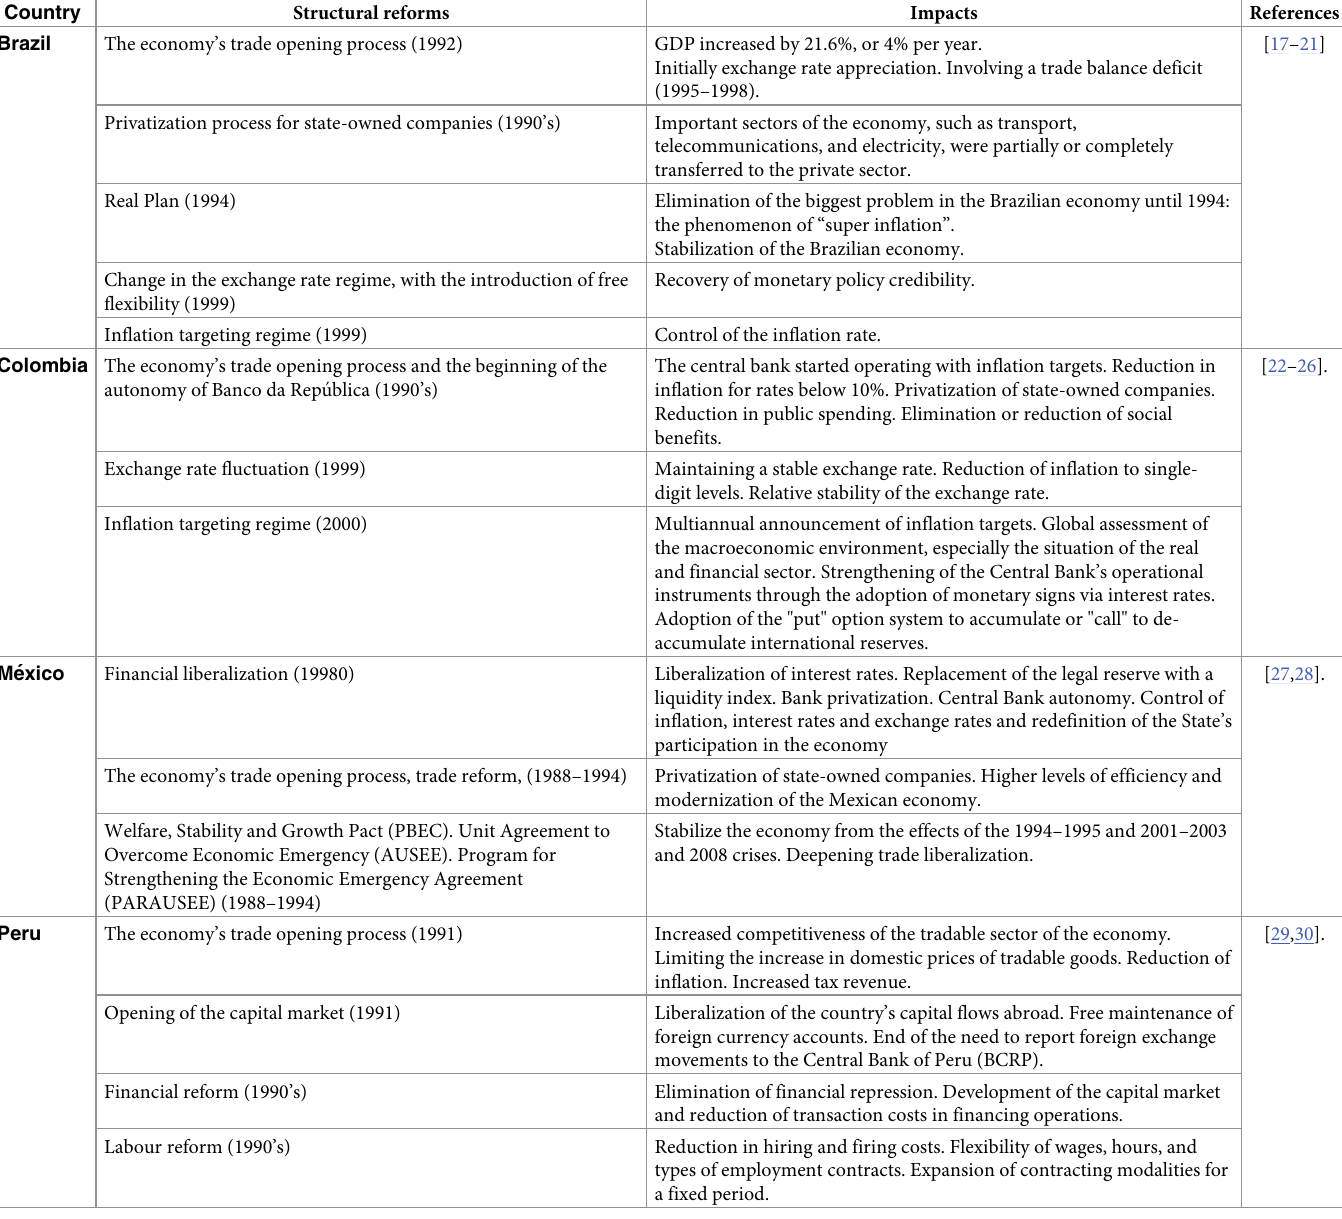
Table 1. Main structural reforms in Brazil, Colombia, Mexico, and